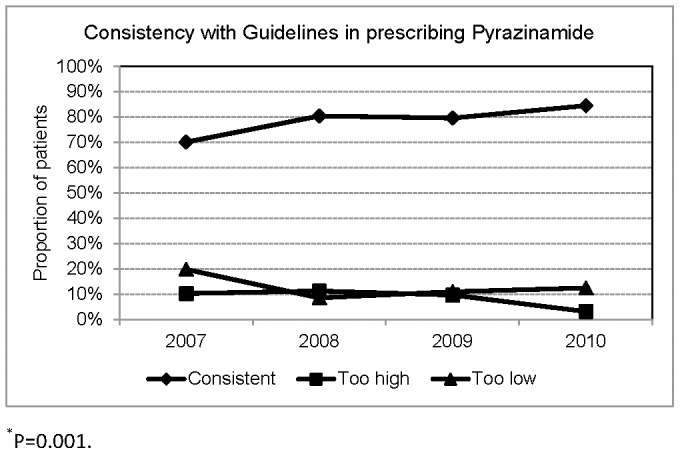
Consistency with Taiwan Guidelines in prescribing Pyrazinamide.